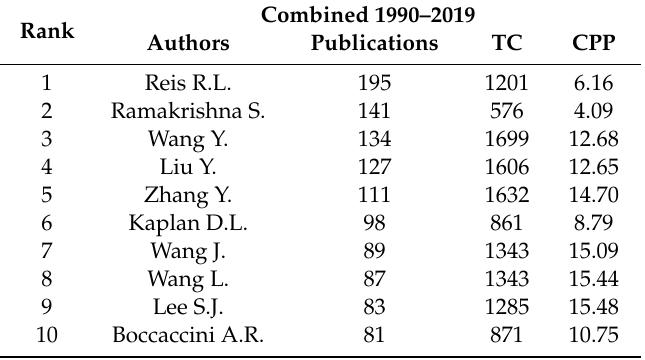
Table 4. The top productive and most cited authors of topic set 1 for 1990 through